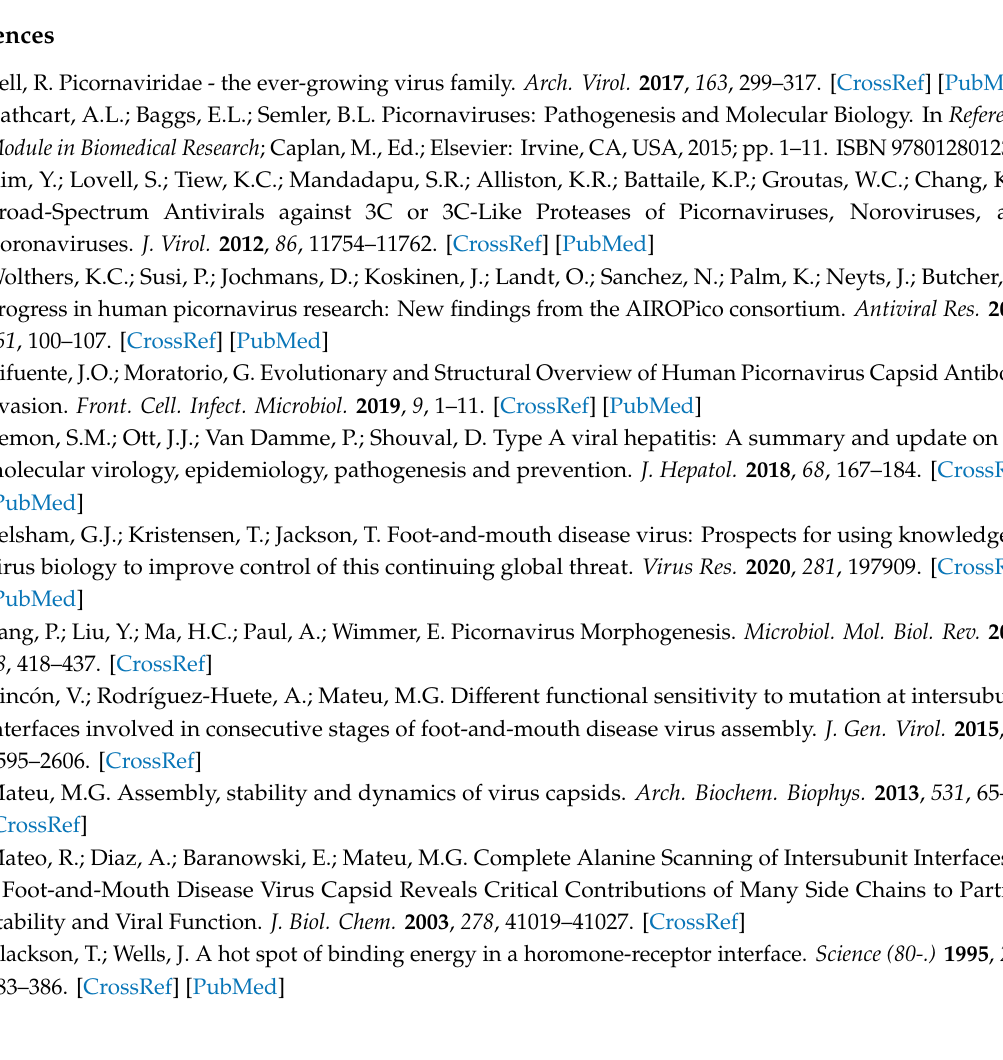
Table S1: Programs that detected hotspot residues at the intraprotomer interface. Table S2: Programs that detected hotspot residues at the interprotomer interface. Table S3: Programs that detected hotspot residues at the interpentamer interface. Figure S1. Sequence-based alignment of TMEV, cardiovirus, senecavirus, aphthovirus and enterovirus VP1 proteins. Figure S2. Sequence- and structure-based alignment of TMEV VP2 with cardiovirus, senecavirus, aphthovirus and enterovirus representatives. Figure S3: Sequence- and structure-based alignment of TMEV VP3 with cardiovirus, senecavirus, aphthovirus and enterovirus representatives. Figure S4: Sequence-based alignment of TMEV, aphthovirus, cardiovirus and enterovirus VP4 proteins. Author Contributions: Conceptualization, N.U., C.R., Ö.T.B. and C.K.; methodology, N.U. and C.R.; formal analysis, N.U.; investigation, N.U.; data curation, N.U.; draft preparation, N.U.; review and editing, C.K., C.R. and Ö.T.B.; visualization, N.U.; supervision, C.K.; All authors have read and agreed to the published version